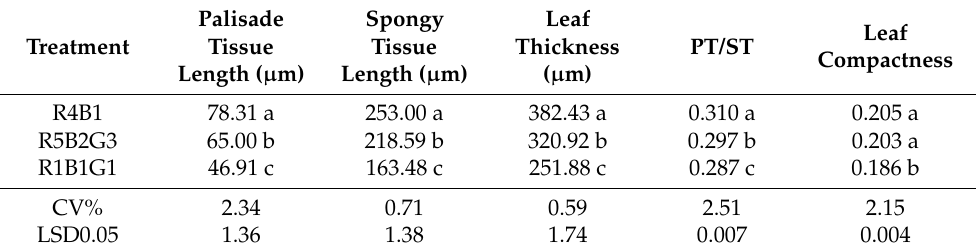
Table 3. Effects of different light qualities on the anatomical structure of hydroponic spinach leaves (30 DAT).